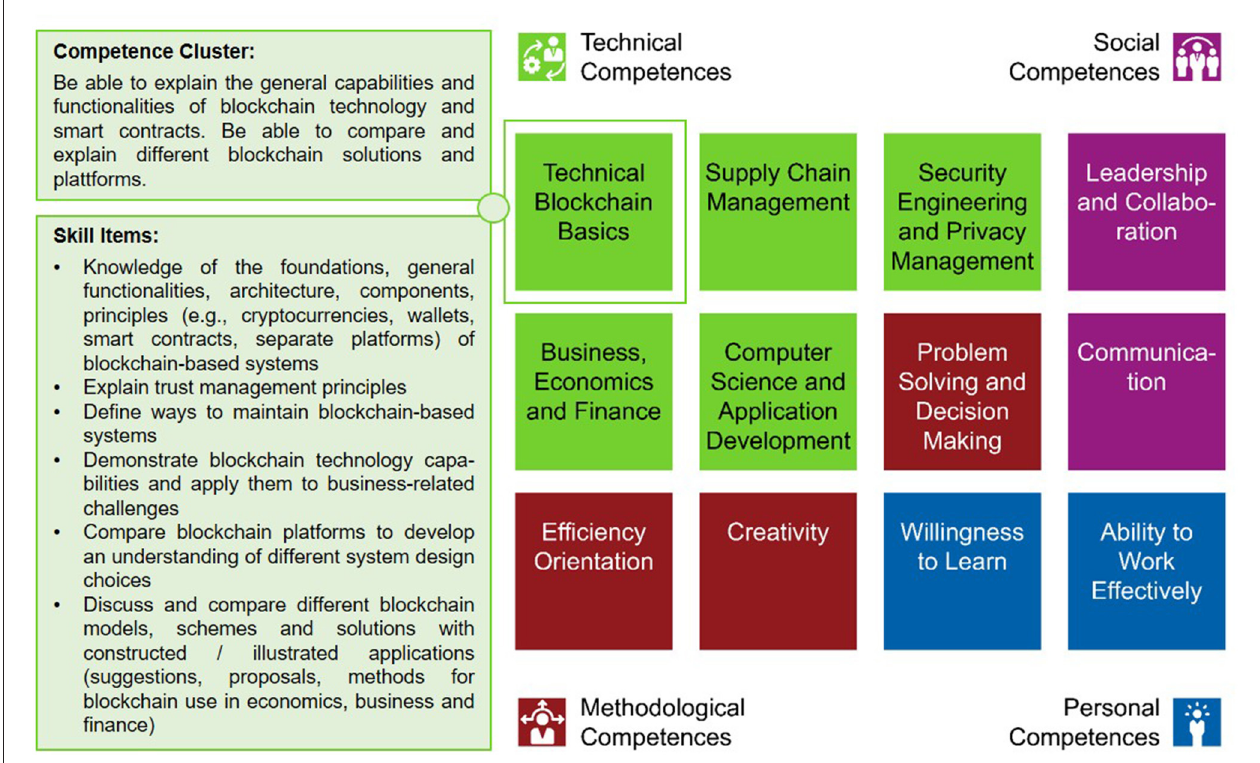
FIGURE 2 | BlockNet competence model. Used with Permission. Graphic by Düdder et al.